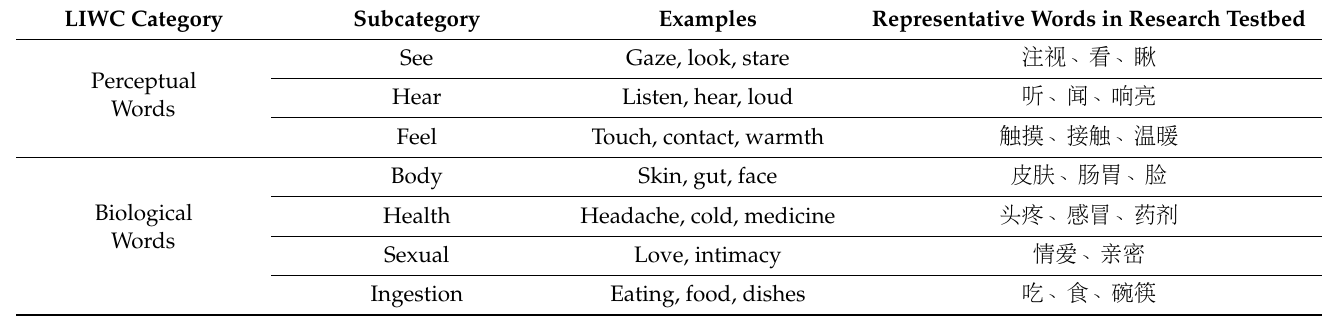
Table A1. LIWC word categories adopted in OHC context. LIWC Category Subcategory Examples Representative Words in Research Testbed